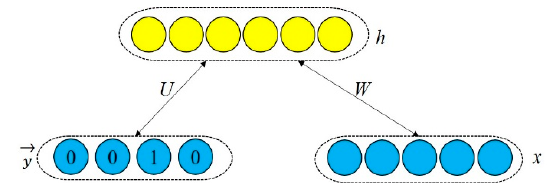
Figure 4. DRBM modelling the joint distribution of inputs and target classes.